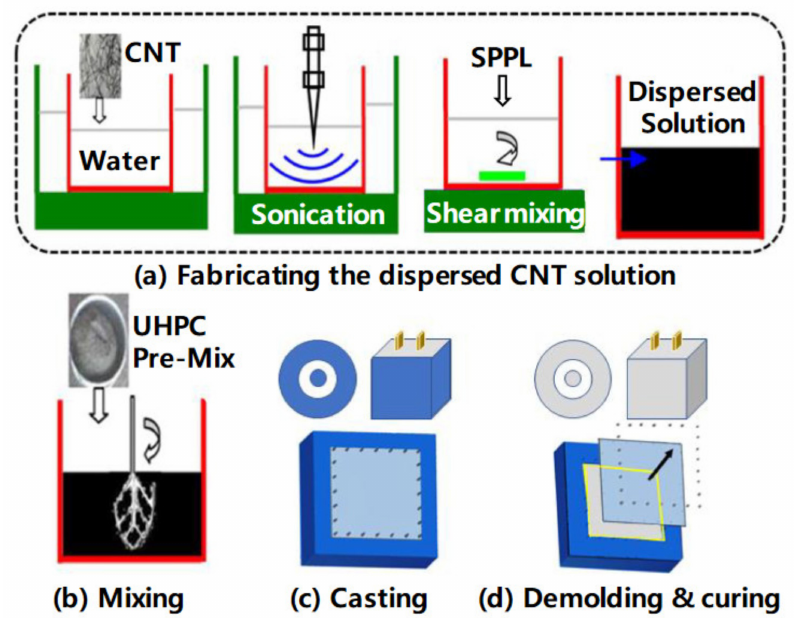
Figure 7. The specimen preparation process for CNT-incorporated ultrahigh-performance concrete. Reproduced from